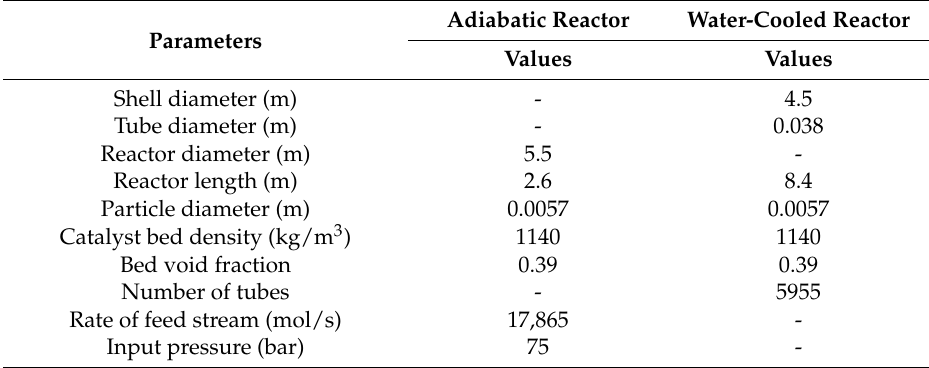
Table 4. The operating conditions and specification of reactors and catalyst of AW